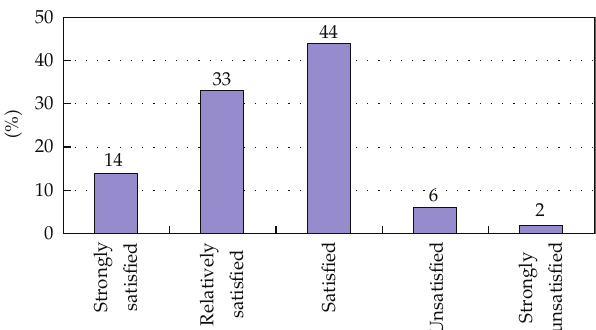
Figure 5: Satisfaction for parking at park and ride facility.